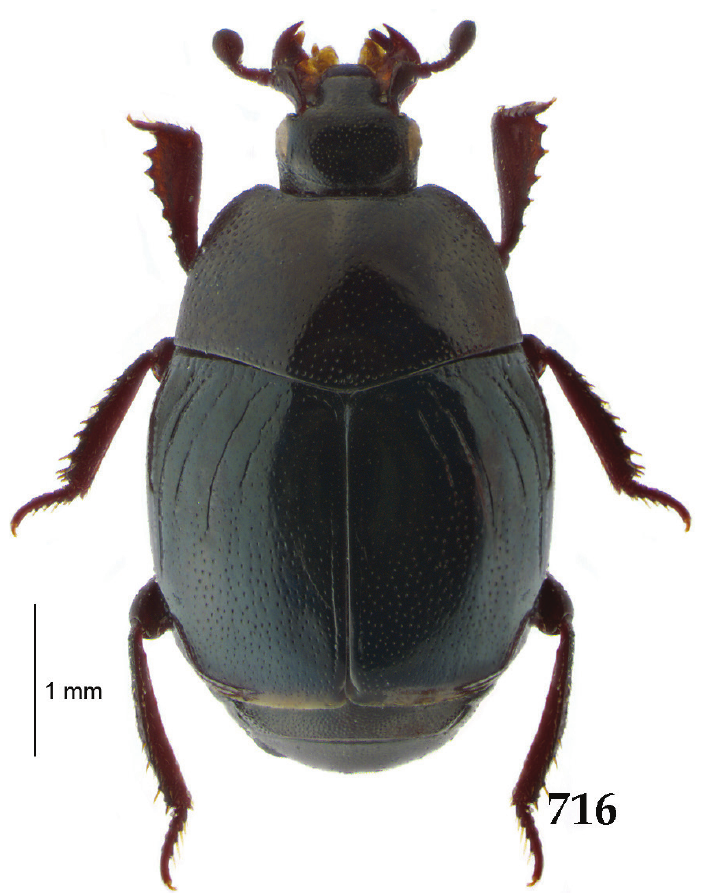
Figure 716. Tomogenius papuaensis Gomy, 2007 habitus, dorsal